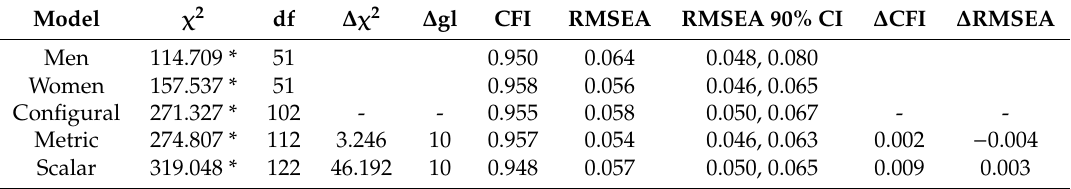
Table 2. Measurement invariance models of the SPANE by gender (reference group: men). Model χ